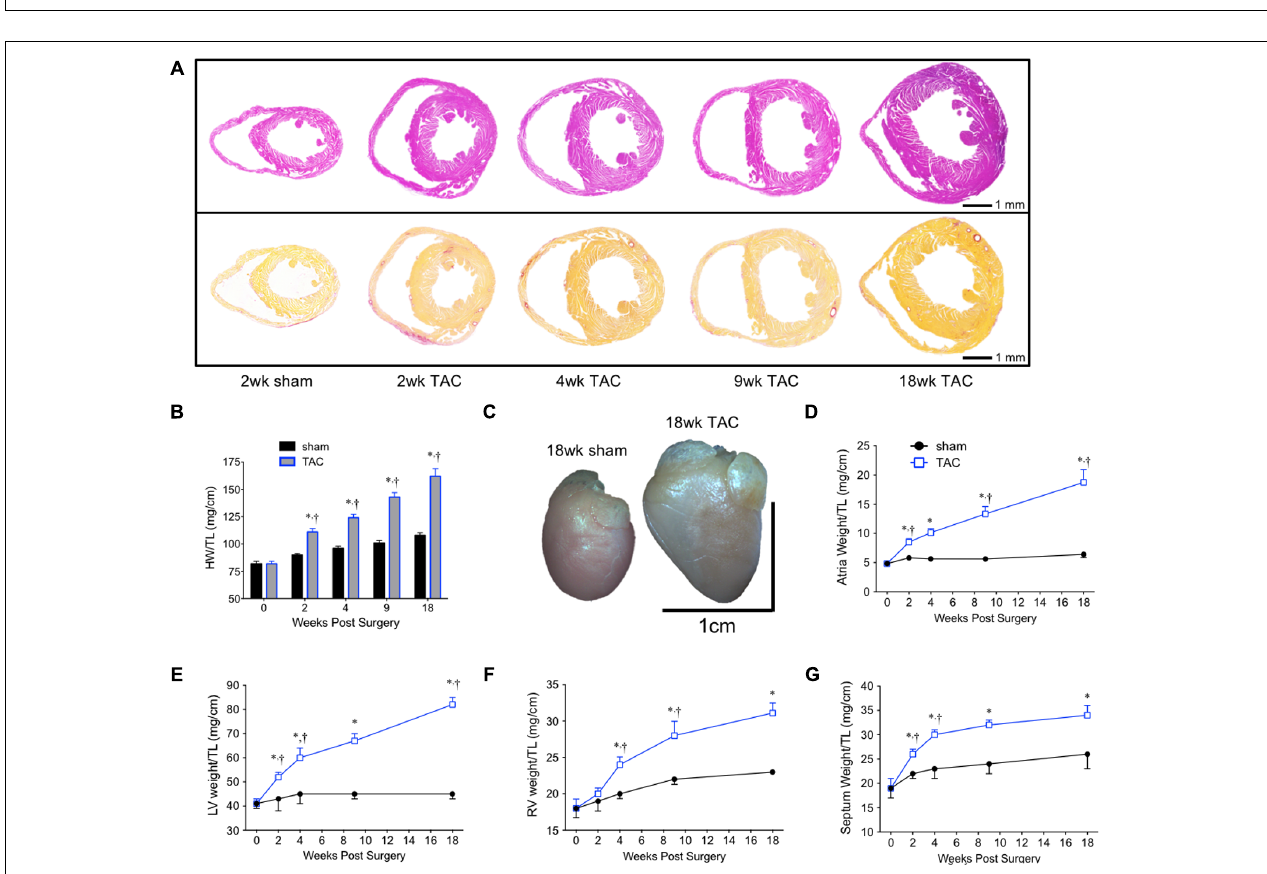
FIGURE 3 | Correlation plots between measures of body growth and cardiac growth in sham mice between 9 and 27 weeks of age ( n = 40). (A) Heart weight/body weight (HW/BW) plotted against body weight. (B) Heart weight/tibial length (HW/TL) plotted against tibial length. The lack of slope in (B) indicates HW/TL is less impacted by growth (i.e., changes in the denominator) than HW/BW. This suggests that normalizing cardiac weight to TL is a better method for determining cardiac hypertrophy between groups of varying weight/age.